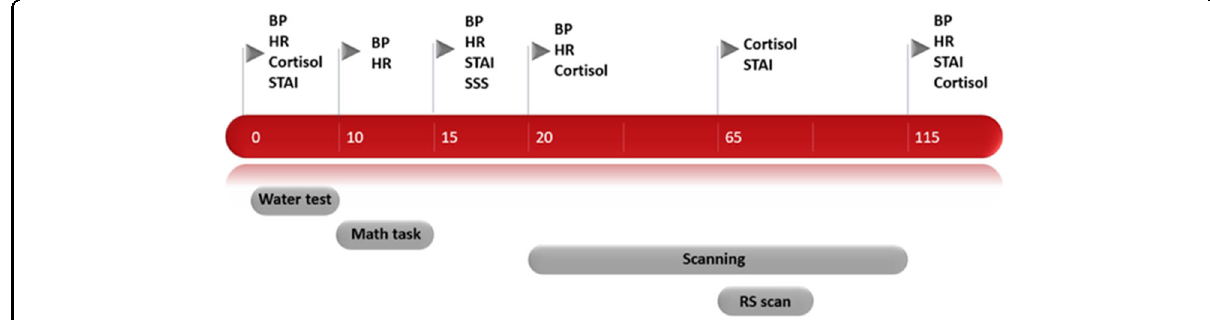
Fig. 1 Timeline of experimental procedure and measurements. Abbreviations: blood pressure (BP), heart rate (HR), State-Trait Anxiety Inventory (STAI), subjective stress scale (SSS) and resting-state (RS)